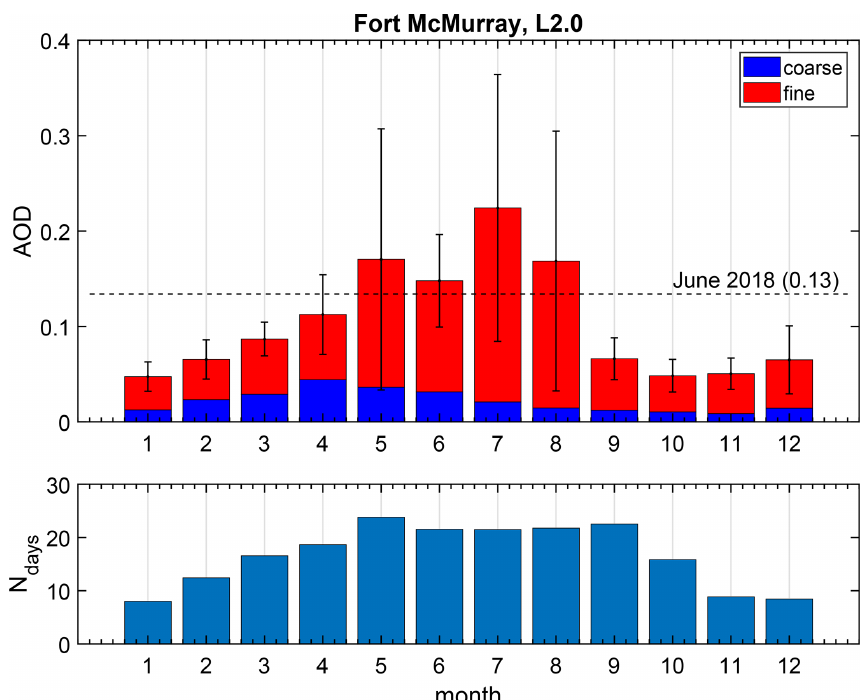
Figure 2. Monthly fine- (red) and coarse-mode (blue) AOD averages for the Fort McMurray AERONET station. The dashed line shows the June 2018 mean total AOD. The error bars represent standard deviations of the (total) monthly mean AODs. The bottom graph shows the mean number of days associated with each monthly binned average. These statistics are for AERONET V3, level 2.0, extinction AODs averaged over the data range from 2005 to 2018